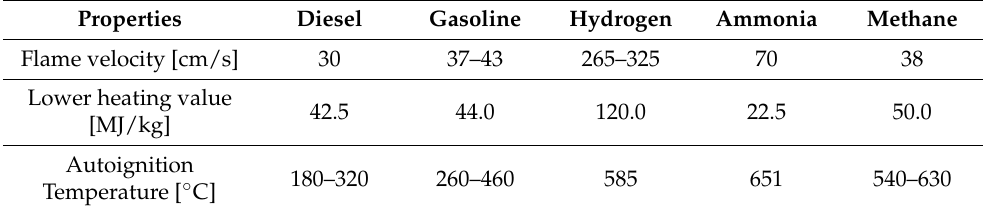
Table 1. List of the main properties of different fuels